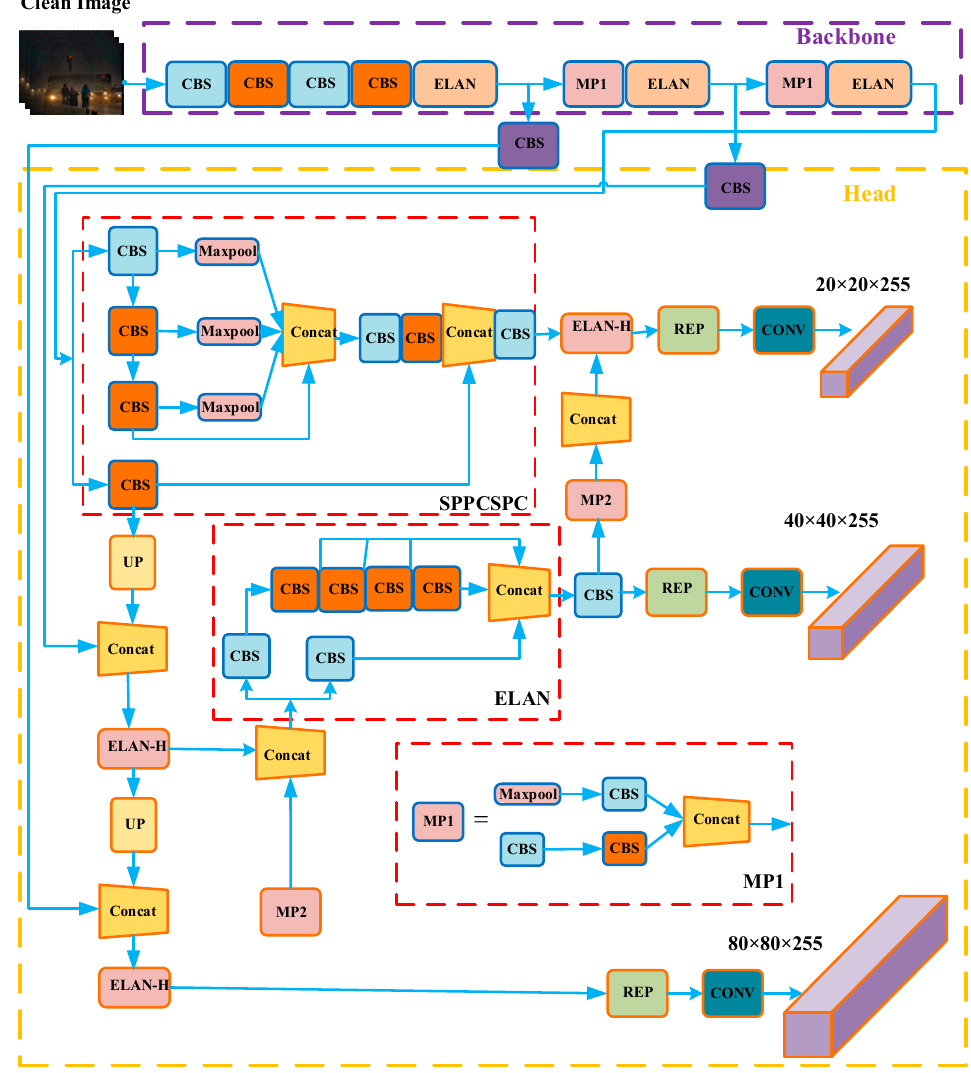
Figure 4. The network architecture diagram of Yolov7 contains four general modules: input terminal, backbone, head, and prediction, and five basic components: CBS, MP, ELAN, ELAN-H, and SPPCSPC.